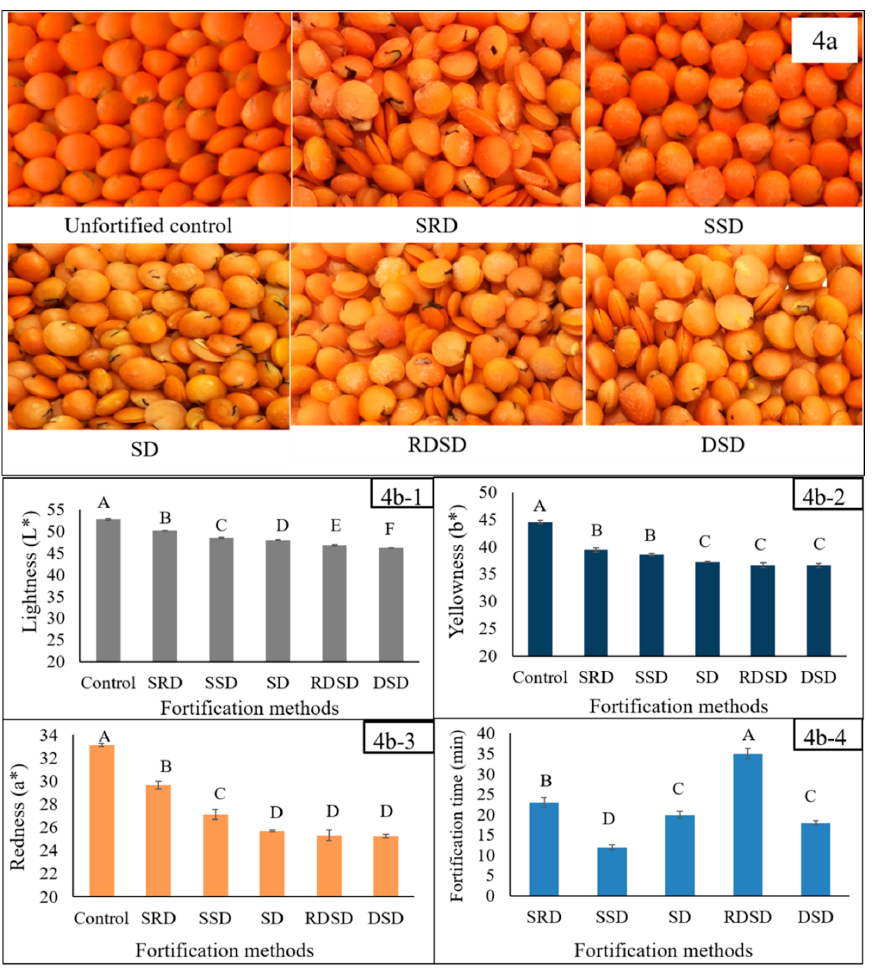
Figure 4. ( a ) Fe-fortified lentil developed by five different fortification methods: SRD = lentil dal soaked in fortificant solution followed by rinsing with deionized water and drying; SSD = lentil dal sprayed with fortificant solution followed by shaking and drying; SD = lentil dal directly soaked in fortificant solution followed by drying; RDSD = lentil dal rinsed, oven dried, followed by soaking in fortificant solution and then drying; DSD = lentil dal oven dried for 10 minutes followed by soaking in fortificant solution and drying at 80 °C; ( b1 – b4 ) Effect of different fortification methods on changes in lightness (L*), yellowness (b*) and redness (a*) score of Fe-fortified lentil dal and on the fortification